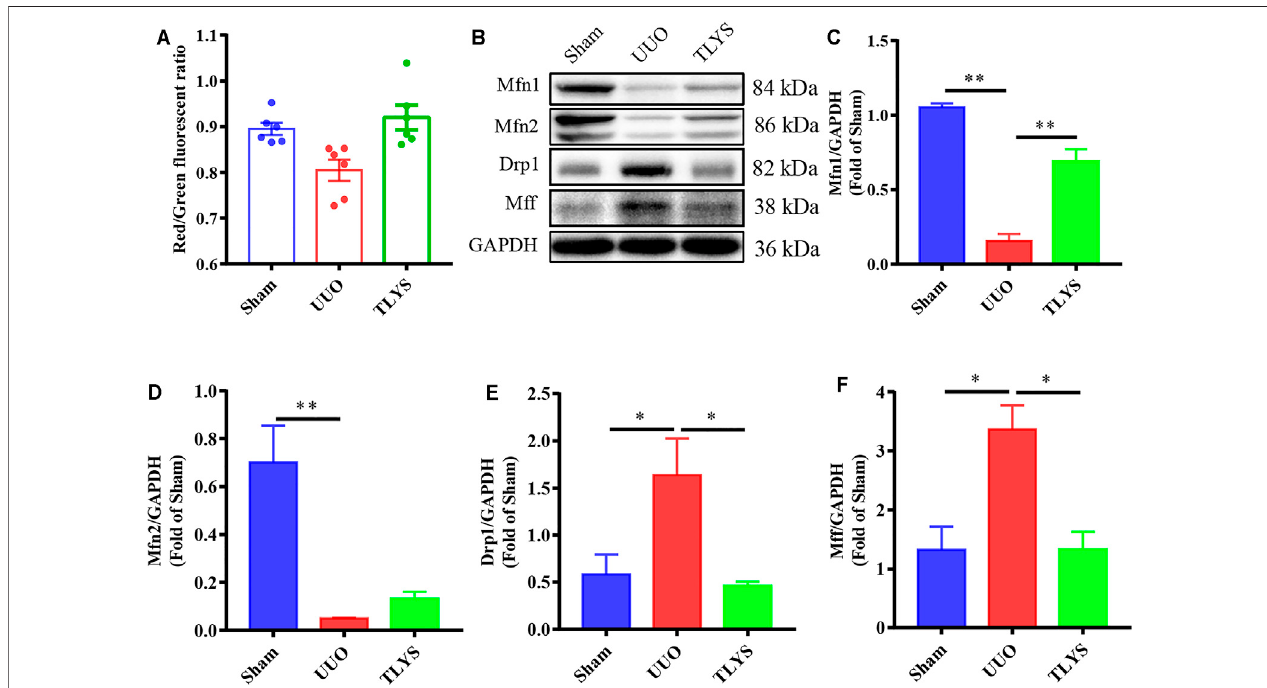
FIGURE 6 | TLYS decoction attenuated mitochondrial function and dynamics in UUO rats. (A) Mitochondrial membrane potential (MMP) assessed using a JC-1 fl uorescence probe ( n (cid:2) 6). (B – F) The protein levels of Mfn1, Mfn2, Drp1, and Mff were assayed by Western blot and analyzed semi-quantitatively. Data were presented as means ± SEM. * p < 0.05, ** p <